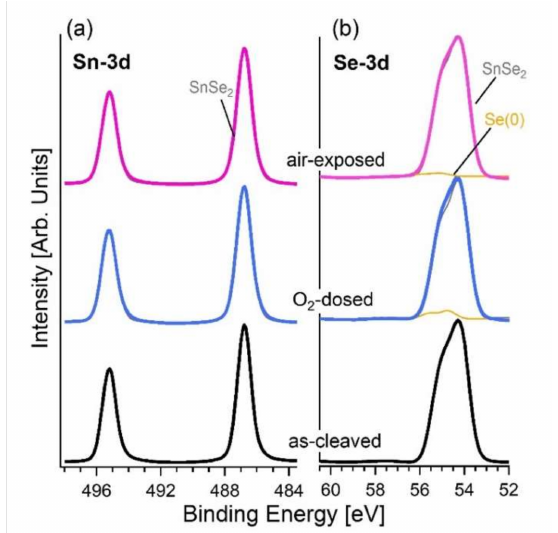
Figure 6. Panels ( a ) and ( b ) show Sn-3d and Se-3d core levels for as-cleaved surface of SnSe 2 and its modification upon O 2 (10 5 L) dosage and air exposure. The photon energy is 800 eV.